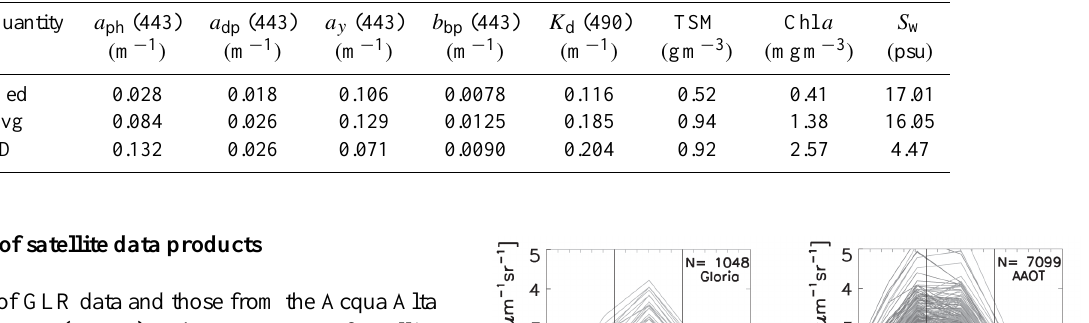
Table 1. Median (Med), mean (Avg) and standard deviation (SD) values of optical properties, concentration of constituents and salinity of the Western Black Sea surface waters (specifically: absorption coefficients of pigmented particles, a ph , non-pigmented particles, a dp , and colored dissolved organic matter, a y , at 443nm; backscattering coefficient of particles, b bp , at 443nm; diffuse attenuation coefficient, K d , at 490nm; concentration of total suspended matter, TSM, and chlorophyll a , Chl a ; and salinity, S w ).